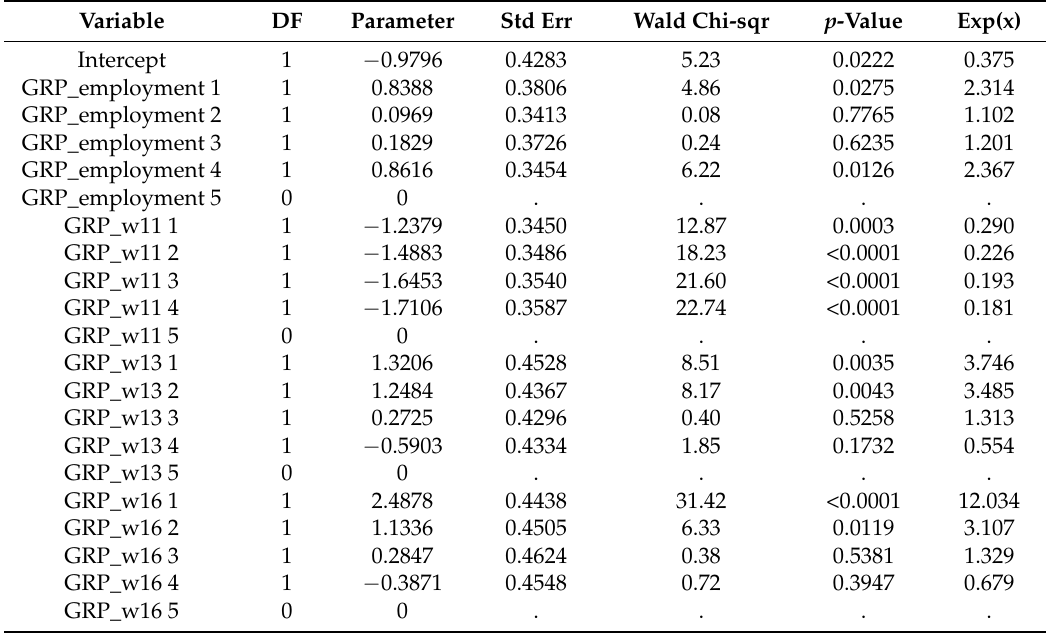
Table 2. Results of estimation of logistic regression with discretized